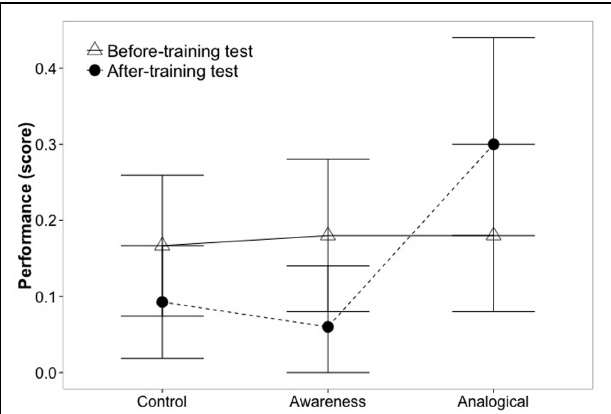
FIGURE 2 | Performance in the different conditions for Insensitivity to sample size. Means and 95% bootstrapped confidence intervals for pre- and post-training tests for each condition are